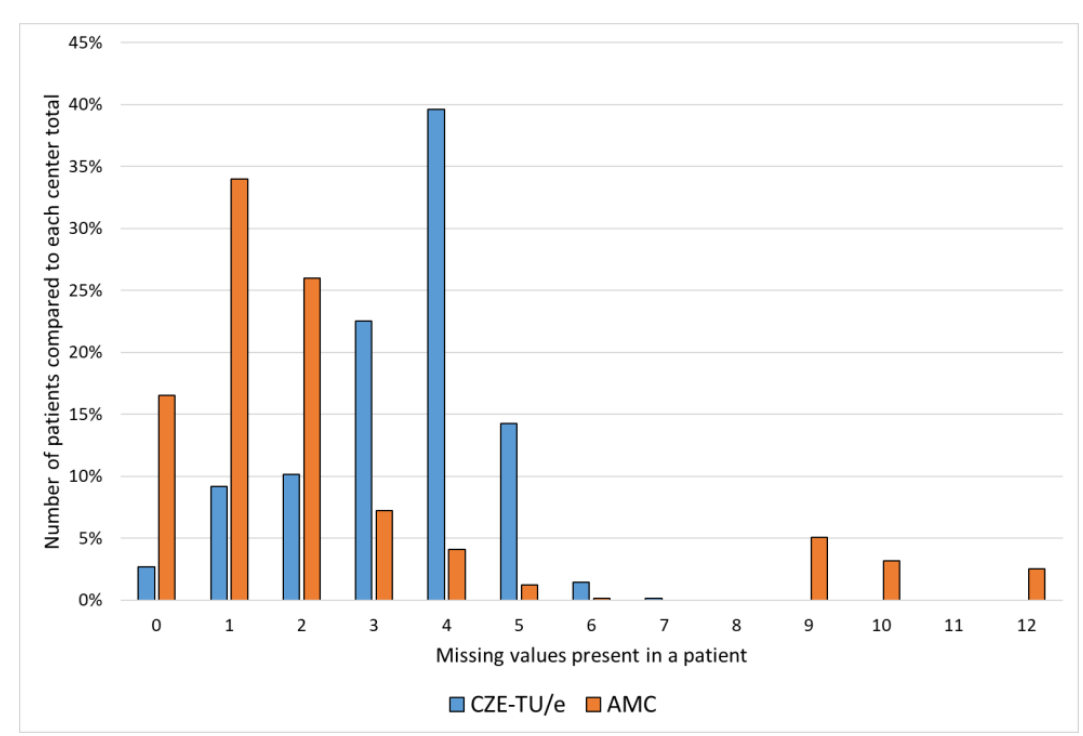
Figure A1. Distribution of missing values per patient on each center population.